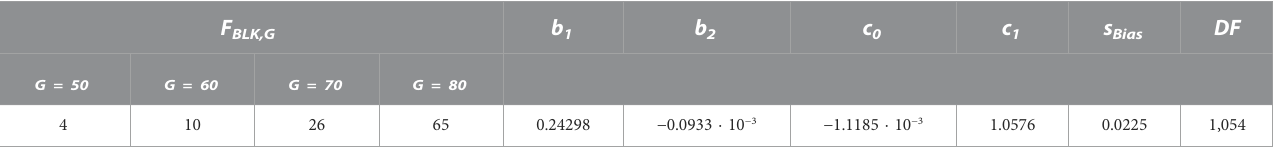
TABLE 1 Coef fi cients of the units conversion model.